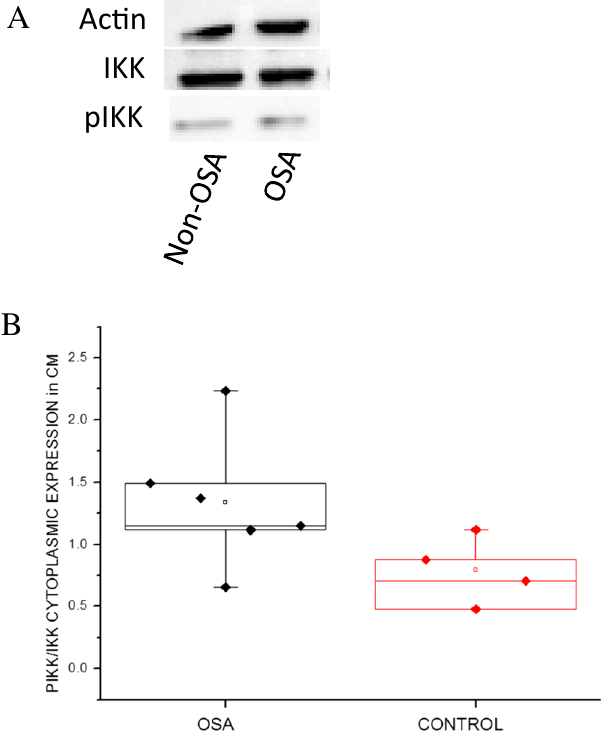
Figure 4. ( A ) Western blot of pIKK and IKK in neonatal rat CM nuclear phase lysate following 2 h exposure to OSA or non-OSA sera. “Non-OSA” refers to 5% Non-OSA patient serum; “OSA” refers to 5% severe OSA patient serum, both in M-119 medium. ( B ) pIKK/IKK ratio levels in nucleus lysates prepared from neonatal rat CM exposed to OSA (black) or non-OSA (red) sera. Horizontal lines represent median values; the upper